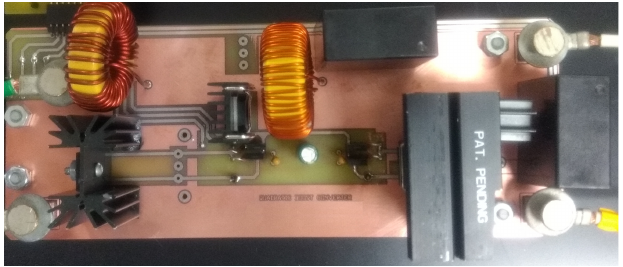
Figure 13. Laboratory prototype of the QBC-SC and QBC-SS converters.